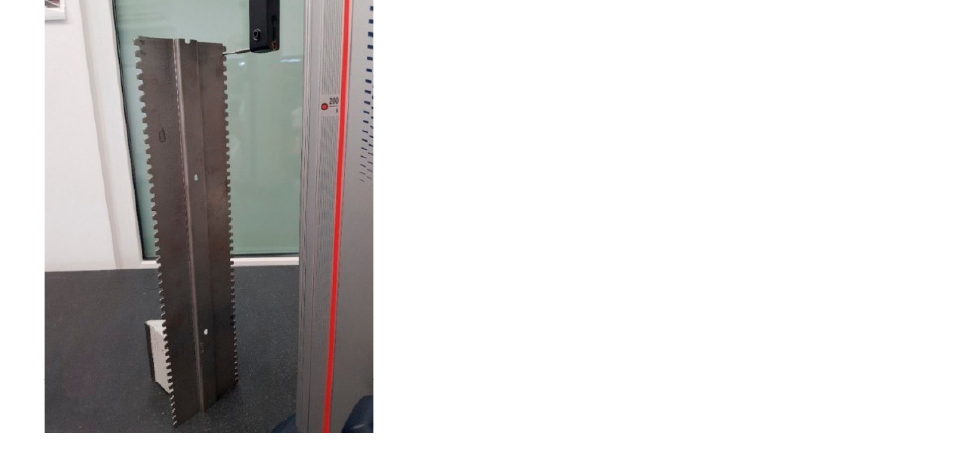
Figure 5. Measurement of the pattern with the LH-600 height gauge (the pattern is placed on the plate and fixed with a magnetic prism) (own study).